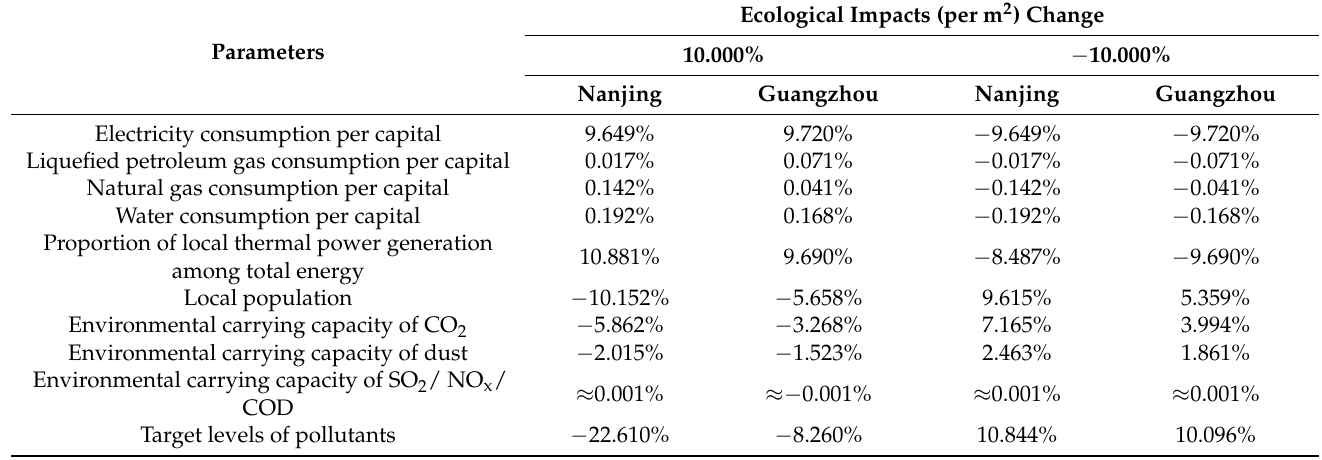
Table 1. Sensitivity analysis of